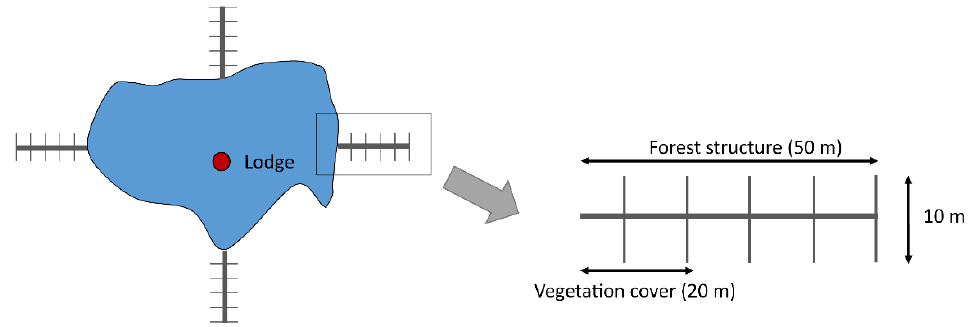
Figure 2. Schematic diagram of transect placement around beaver pond samples.